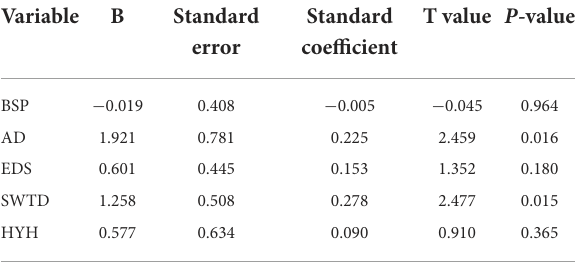
TABLE 5 Multiple linear regression model for SNAP-IV scores.